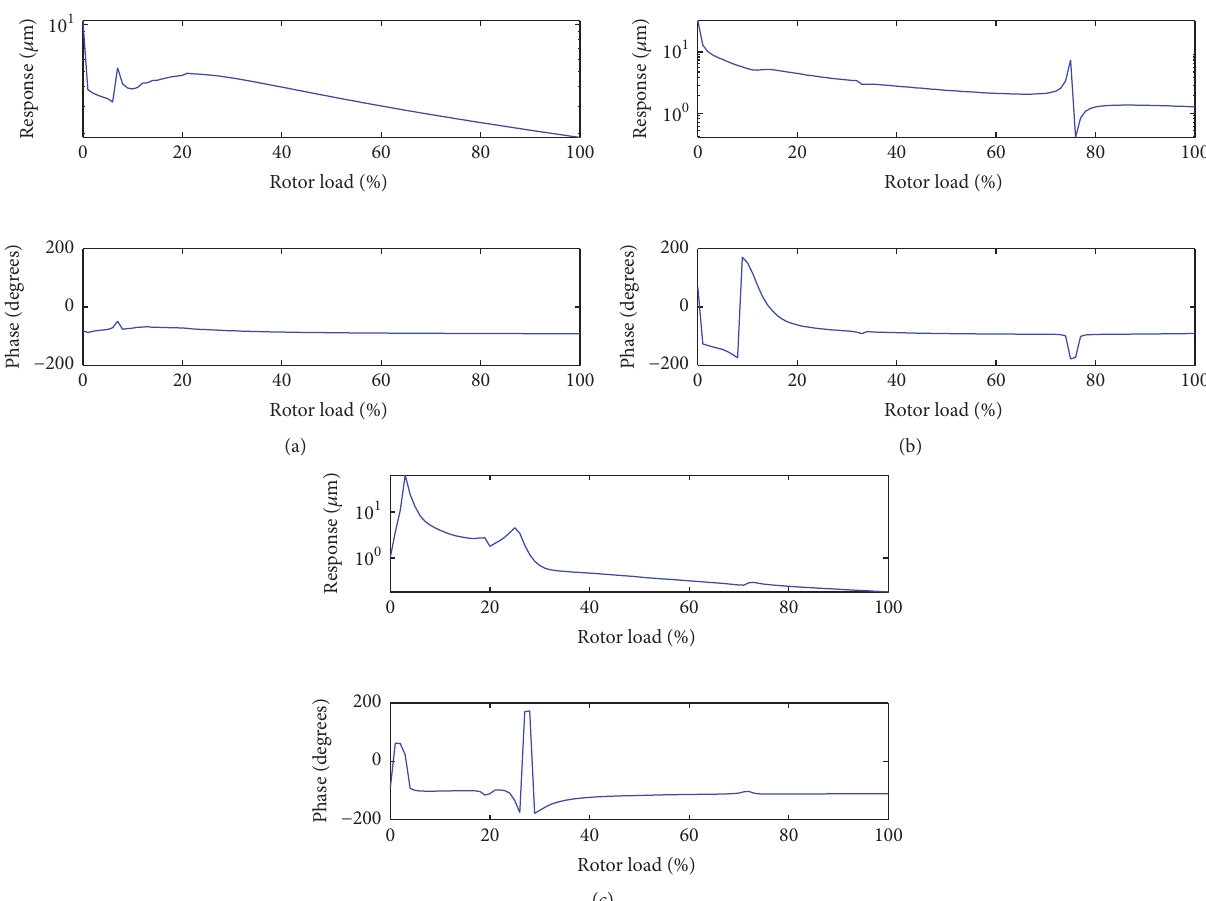
Figure 16: Response and phase under different workloads when three output shafts are running at the rated speed, (a) output shaft 1 running at 11131r/min; (b) output shaft 2 running at 13297 r/min; (c) output shaft 3 running at 20841 r/min.